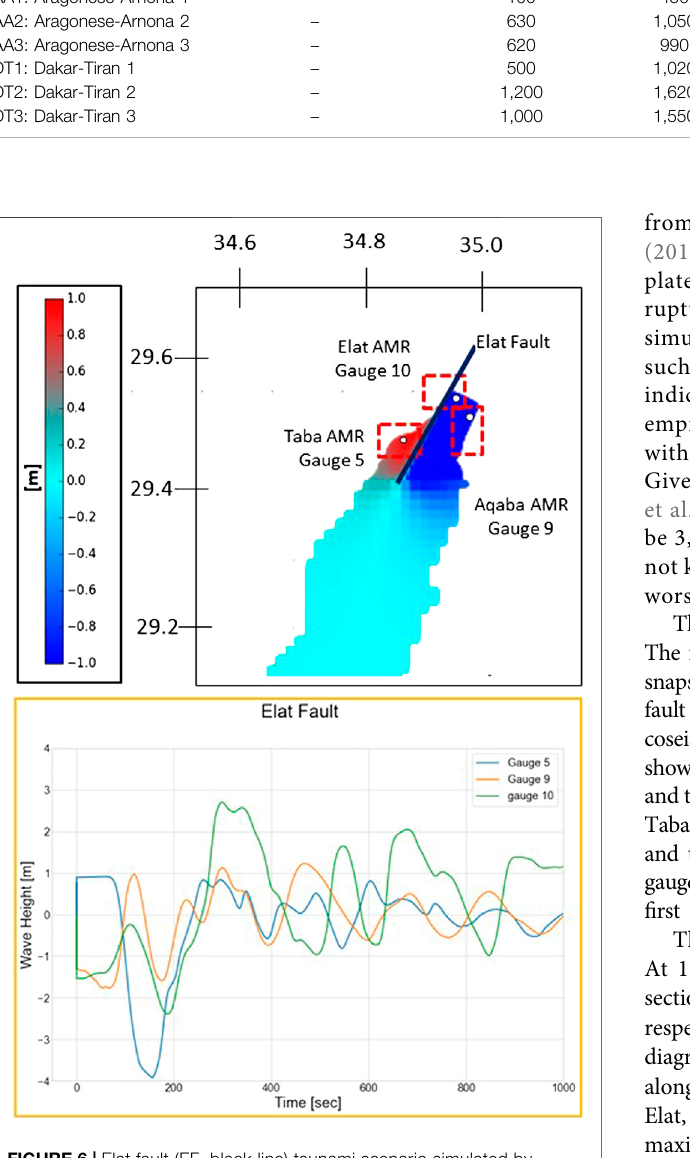
Frontiers in Earth Science |